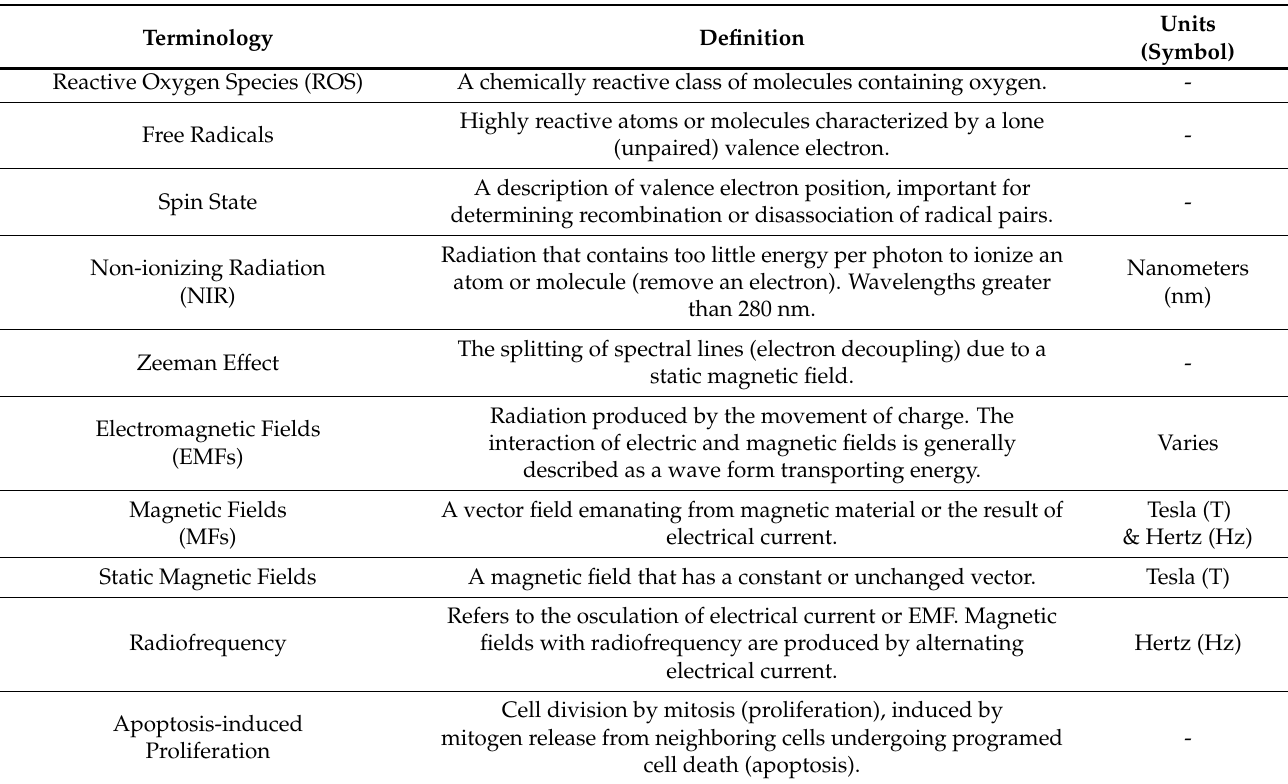
Table 1. Brief definitions for some of the terminology used in this